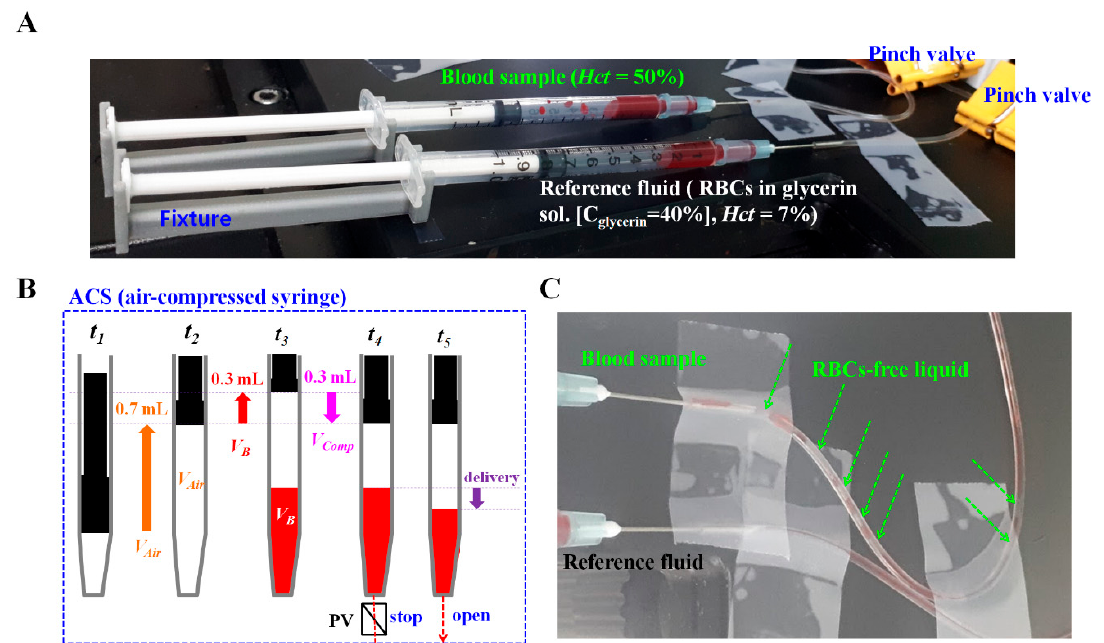
Figure A1. Fabrication and operation of the air-compressed syringe. ( A ) Two air-compressed syringes (ACSs) filled with blood sample ( Hct = 50%) and reference fluid (RBCs in 40% glycerin sol. [ Hct = 7%]). Each ACS was composed of a disposable syringe (~ 1mL), a fixture, and a pinch valve. ( B ) Operation of ACS: piston movement at the lowest position forward at t = t 1 , air suction ( V Air = 0.7 mL) by moving piston to 0.7 mL backward at t = t 2 , blood suction by moving piston to 0.3 mL backward ( V B = 0.3 mL) at t = t 3 , air compression by moving piston to 0.3 mL forward ( V comp = 0.3 mL) at t = t 4 , and blood delivery by removing pinch valve at t = t 5 . Similarly, the reference fluid was sucked into the syringe instead of blood. The remaining procedure was the same as blood delivery with the ACS. The blood sample and reference fluid were then delivered into the corresponding inlets with two ACSs. ( C ) Snapshots for showing RBC-free liquid in a tube under blood delivery using an ACS. Owing to the continuous erythrocyte sedimentation rate (ESR) inside the ACS, a red blood cell (RBC)-free liquid was observed in the microfluidic channel after a certain lapse of time.